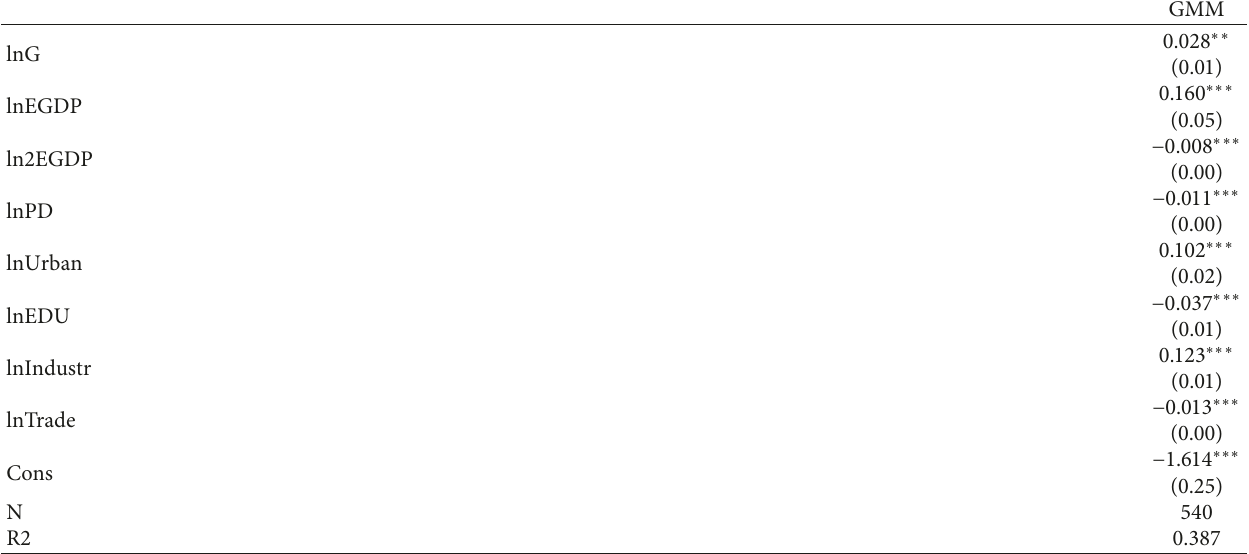
Table 8: Endogenous test.